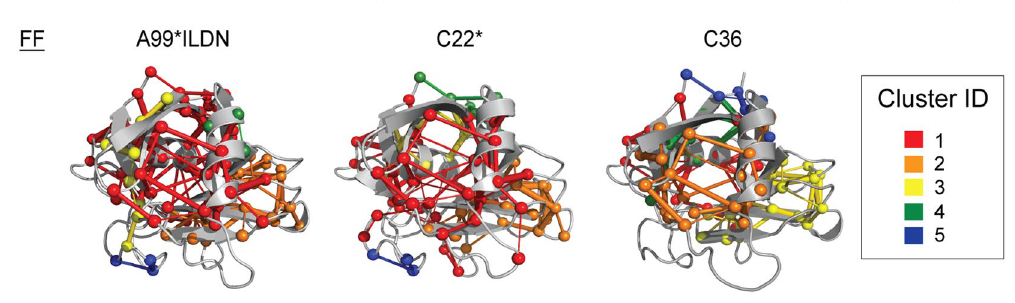
Figure 7. Location of the first five connected components on the 3D structure of CypA. We mapped on CypA 3D structure the PSN connected components identified in CypA MD simulations with the three different force fields CHARMM22 * (C22 * ), CHARMM36 (C36) and Amber99SB * -ILDN (A99 * ILDN). The different colors range from red to blue for the largest and smallest clusters, respectively. The nodes are represented as spheres while the edges are visualized as cylinders. The figure has been produced with the xPyder plugin 65 for